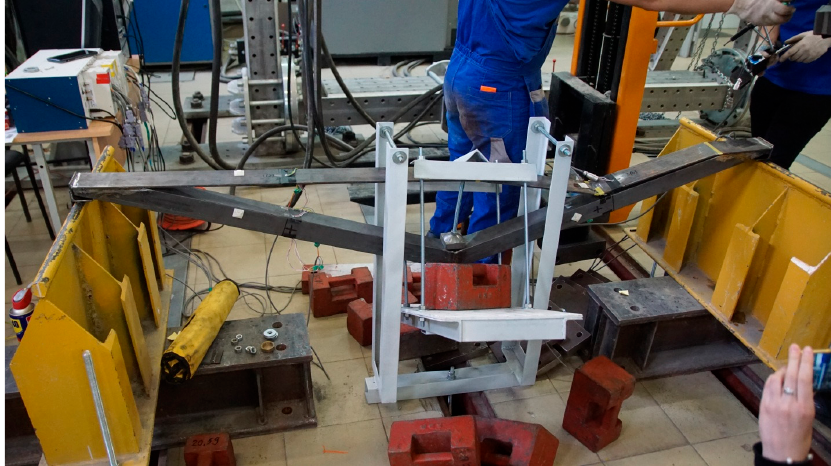
Figure 21. Truss after the destruction of the upper belt. Experiment No. 3.